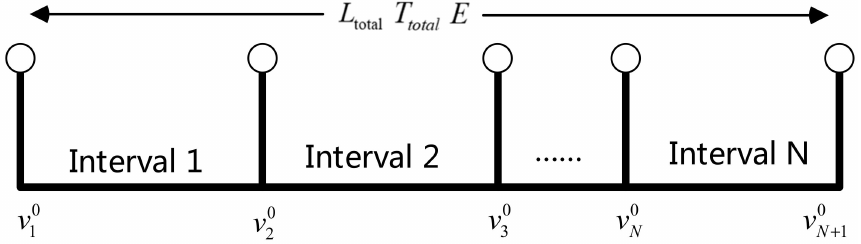
Figure 3. Train multi-interval operation